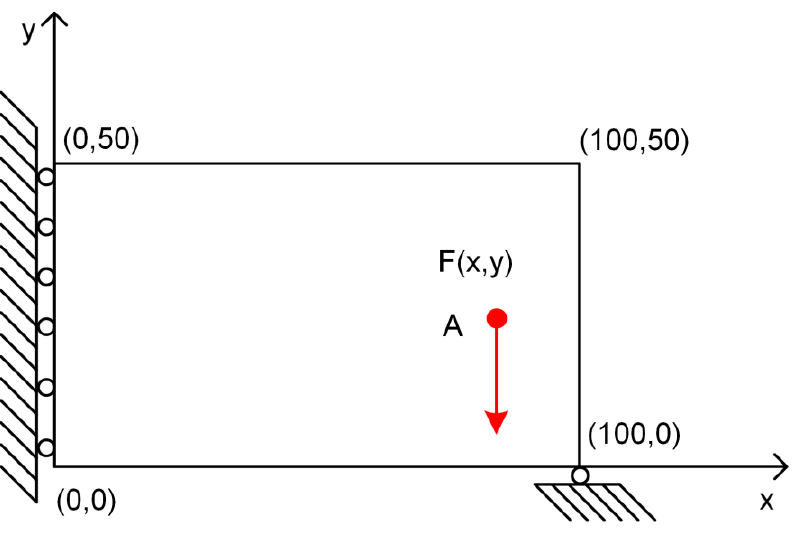
Figure 1. Design domain and load distribution of the MBB beam.